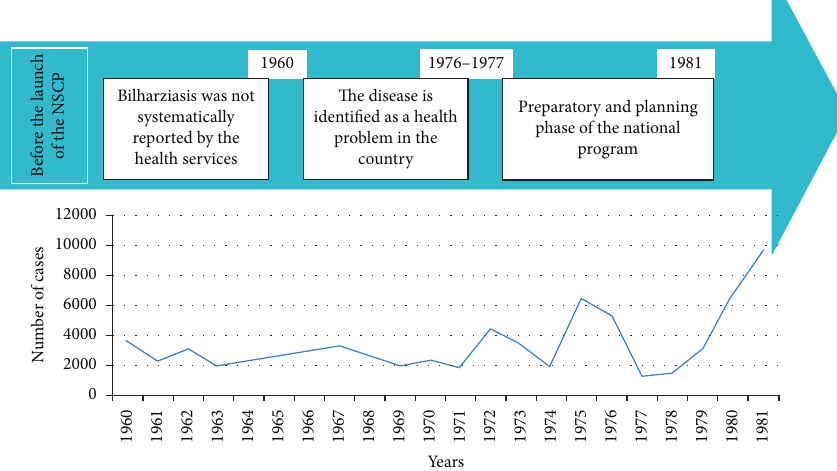
Figure 1: Evolution of schistosomiasis before the establishment of the national schistosomiasis control